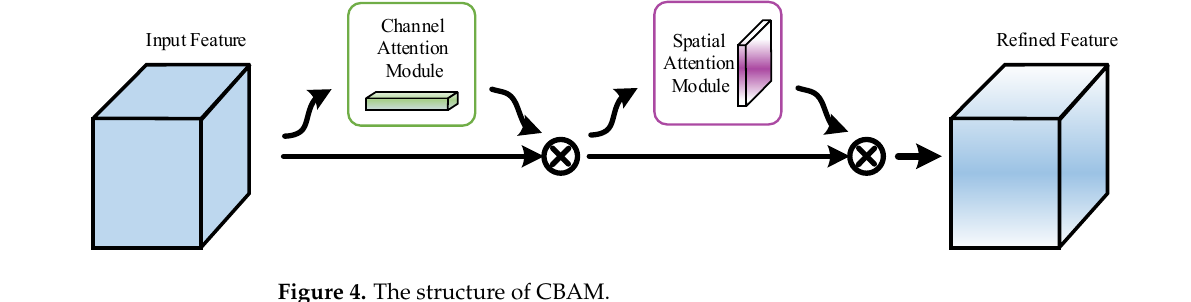
Figure 5. The network structure of CAM. Figure 6. The network structure of SAM. Firstly, we performed the average pooling operation and the maximum pooling op ‐ eration on the feature maps